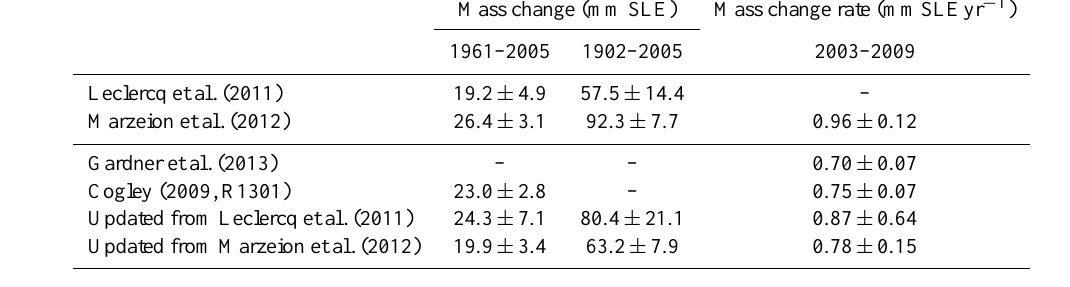
Table 1. Globally integrated glacier mass change reconstructions. Note that all reconstructions exclude glaciers in the Antarctic periphery.